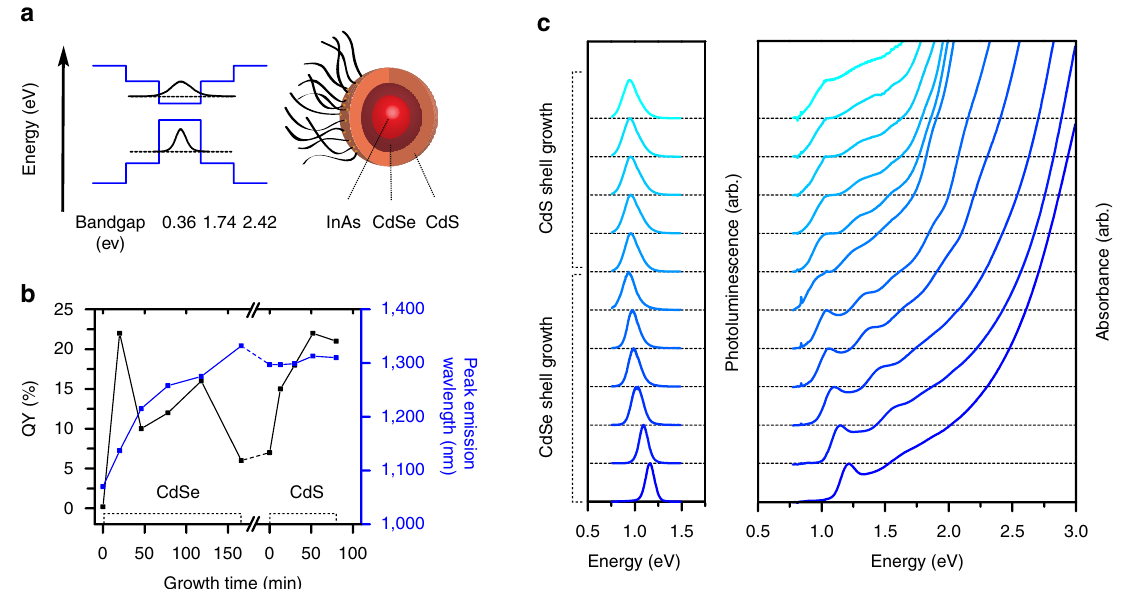
Figure 3 | Synthesis of core-shell-shell QDs. ( a ) Schematic band alignment in InAsCdSeCdS CSS QDs, based on values provided in refs 14,43. ( b ) Growth of two shells onto an InAs QD. While the CdSe shell leads to a strong redshift in the PL peak, the QY initially increases and then decreases during shell growth, indicative of the formation of a quasi type-II structure. The position of the PL peak stays approximately constant during growth of the outer CdS shell, while the QYshows steady improvements, indicative of the formation of a type-I structure. ( c ) Respective PL and absorbance spectra for the growth of InAsCdSeCdS